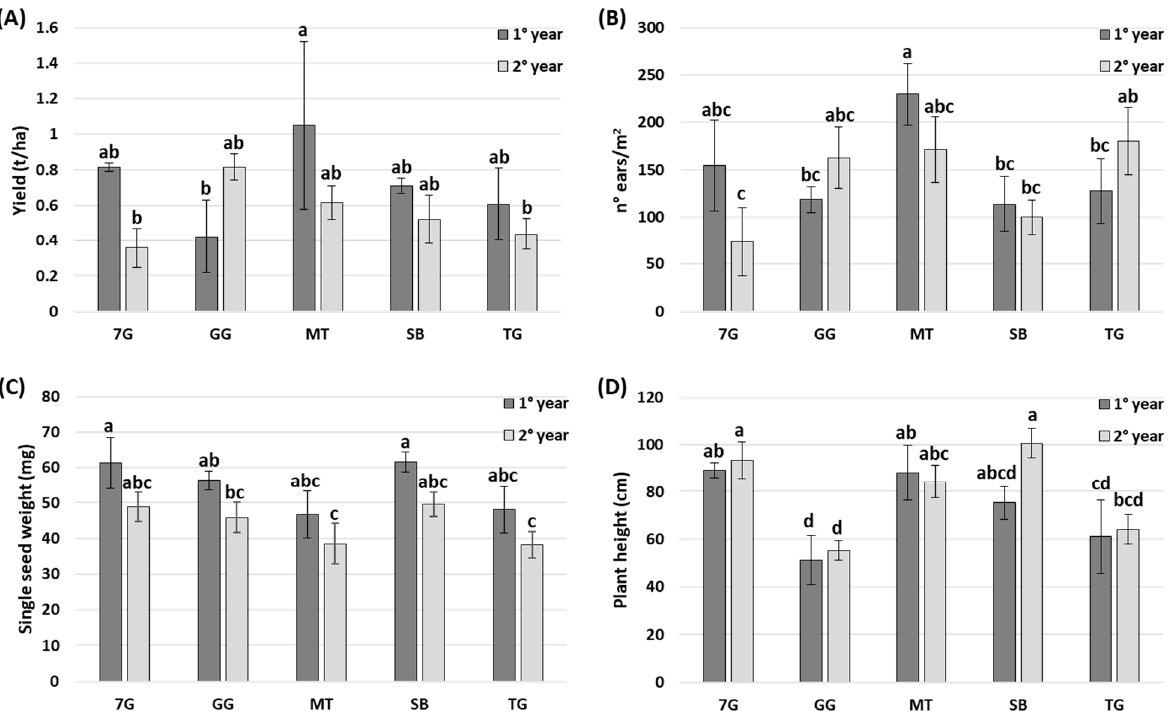
Figure 1. The measured yield ( A ), n ◦ ears/m 2 ( B ), single-seed weight ( C ) and plant height ( D ) of five wheat varieties in Varchignoli. For each parameter measured, different letters indicate statistically significant differences (Tukey’s test, p < 0.05).